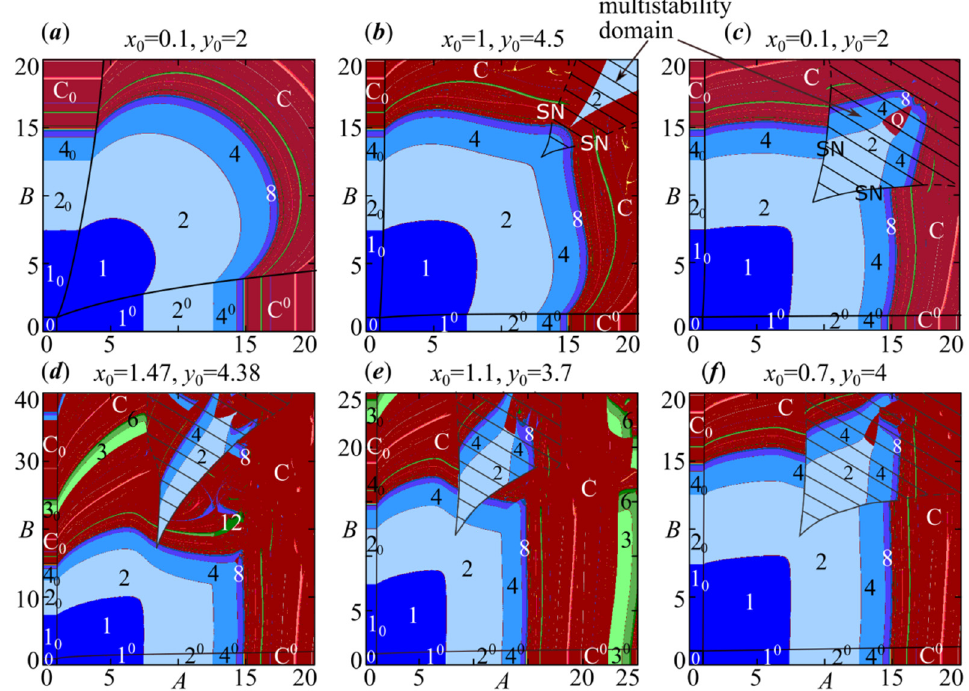
Figure 5. Dynamic mode maps of model (4) for different values of parameters φ and ρ : ( a ) ρ = φ = 0.5; ( b ) ρ = φ = 0.1; ( c ) ρ = φ = 0.03; ( d ) ρ = 0.01, φ = 0.2; ( e ) ρ = 0.01, φ = 0.1; ( f ) ρ = 0.01, φ = 0.05. Figures correspond to the period of observed cycles. Q stands for quasiperiodic dynamics, C is chaotic dynamics and 0 corresponds to the community extinction. The subscript and superscript 0 correspond to the extinction of species x and y , respectively. Several coexisting modes are possible in the shaded area.